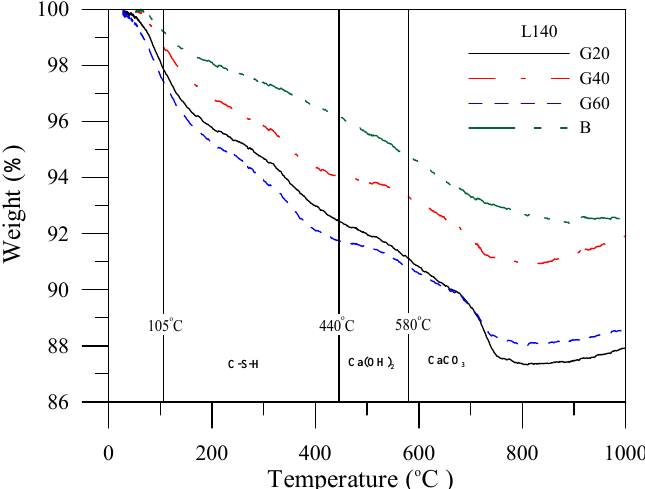
Figure 16. Weight loss of the specimens with slag admixture after leaching vs. temperature